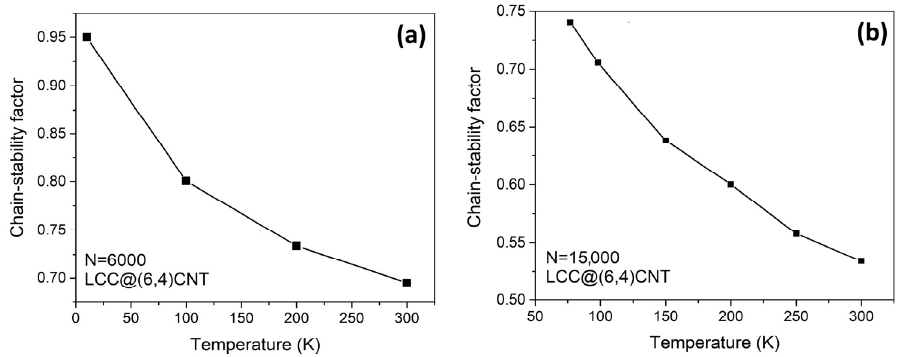
Figure 4. An LCC encapsulated by a (6,4)CNT during heating. The atomic fluctuations of the LCC depend on the chain length and temperature. ( a ) The LCC consists of 6000 atoms. ( b ) The LCC contains 15,000 atoms.